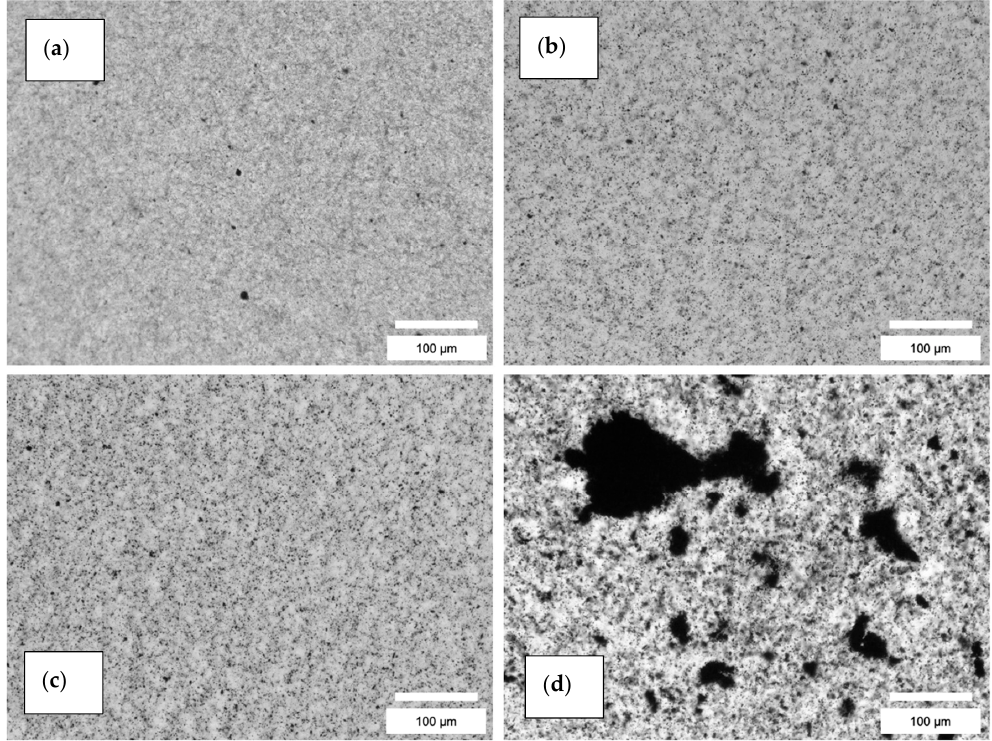
Figure 4. Comparison of different nanofiller dispersed in resin (TRM): ( a ) 0.5 wt% CNF; ( b ) 0.5 wt% CNToxi; ( c ) 0.5 wt% CNT; ( d ) 0.5 wt% CNT